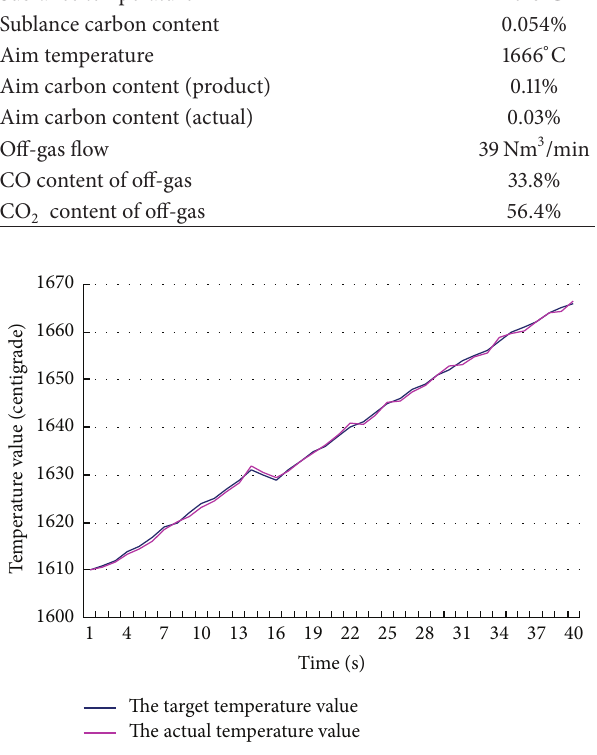
Figure 4: Dynamic curves between the actual temperature and the target